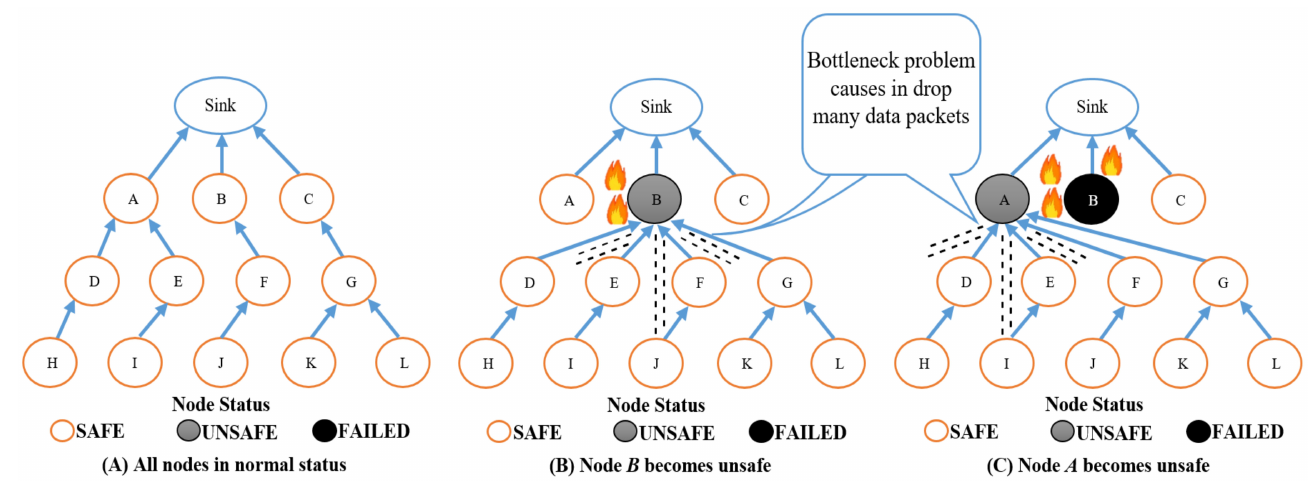
Figure 2. The PCE-OLSR